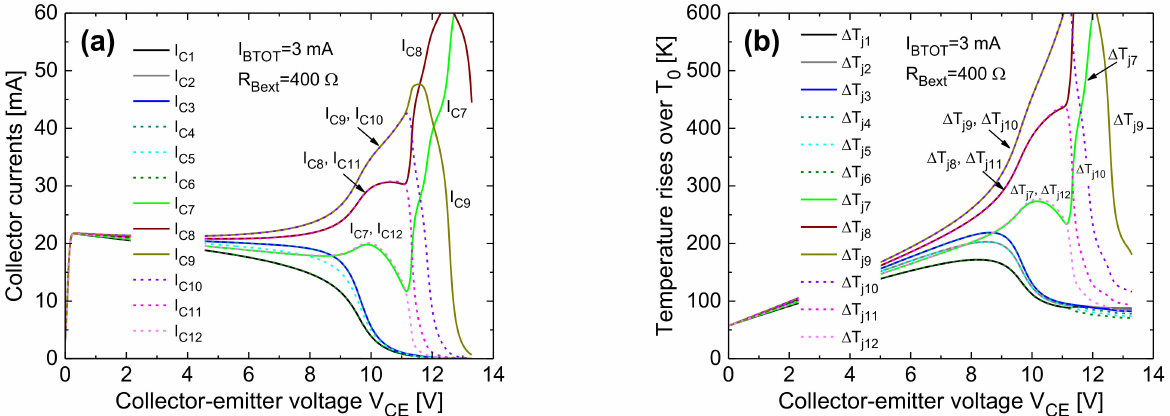
Figure 20. Simulated ( a ) collector currents and ( b ) junction temperature rises above T 0 for the 12 cells of the halved 24-cell array ballasted with R Bext = 400 Ω per cell, with I BTOT = 3 mA